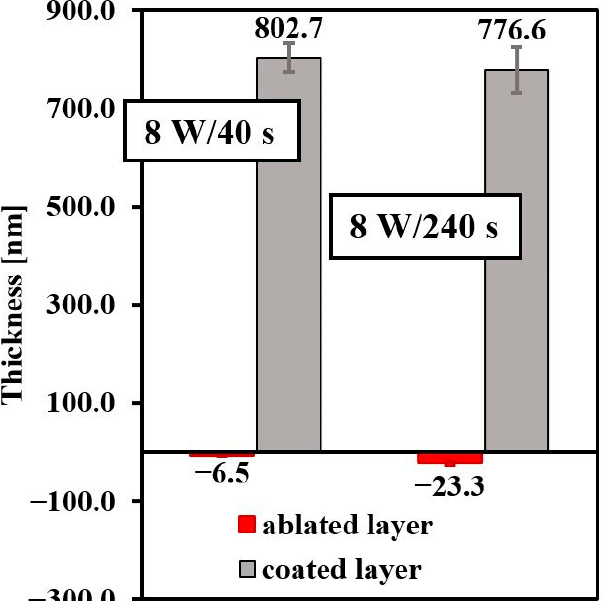
Figure 3. The thickness of an ablated fluorinated ethylene propylene layer after plasma treatment (8 W) and coated with a polystyrene (PS) layer in dependence on exposure time (40 and 240 s).